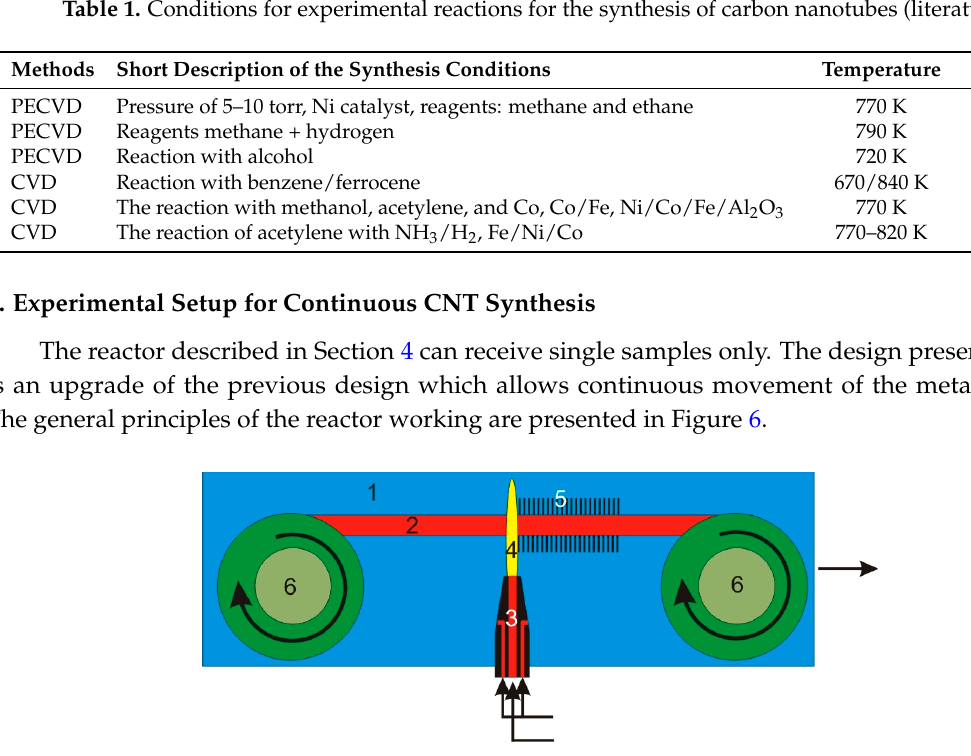
Figure 5. Thermal decomposition of the mixture of 1000 sccm of ethylene with 3000 sccm of hydrogen.